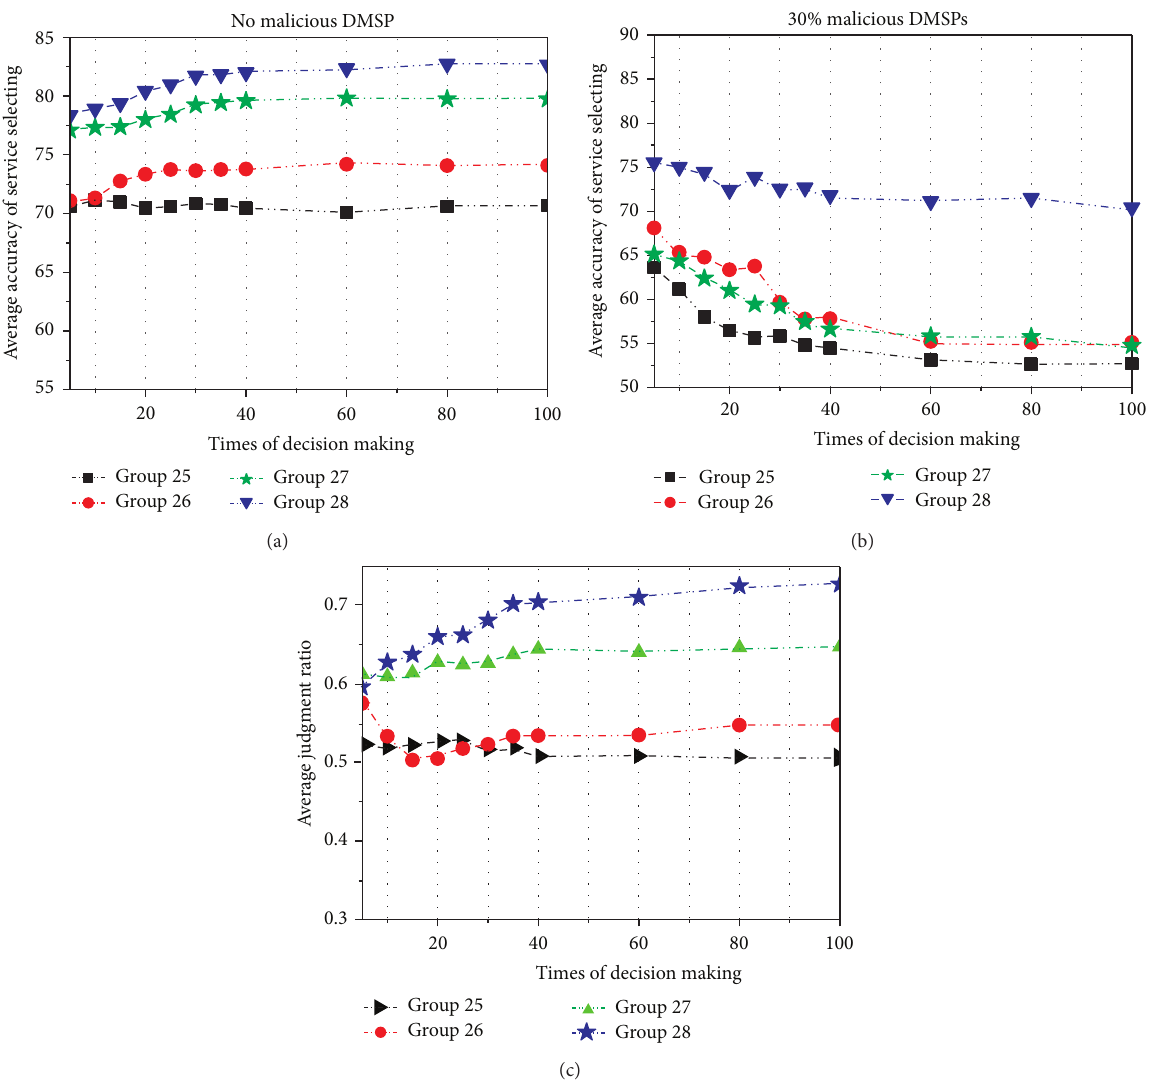
Figure 9: Effects of our service selection